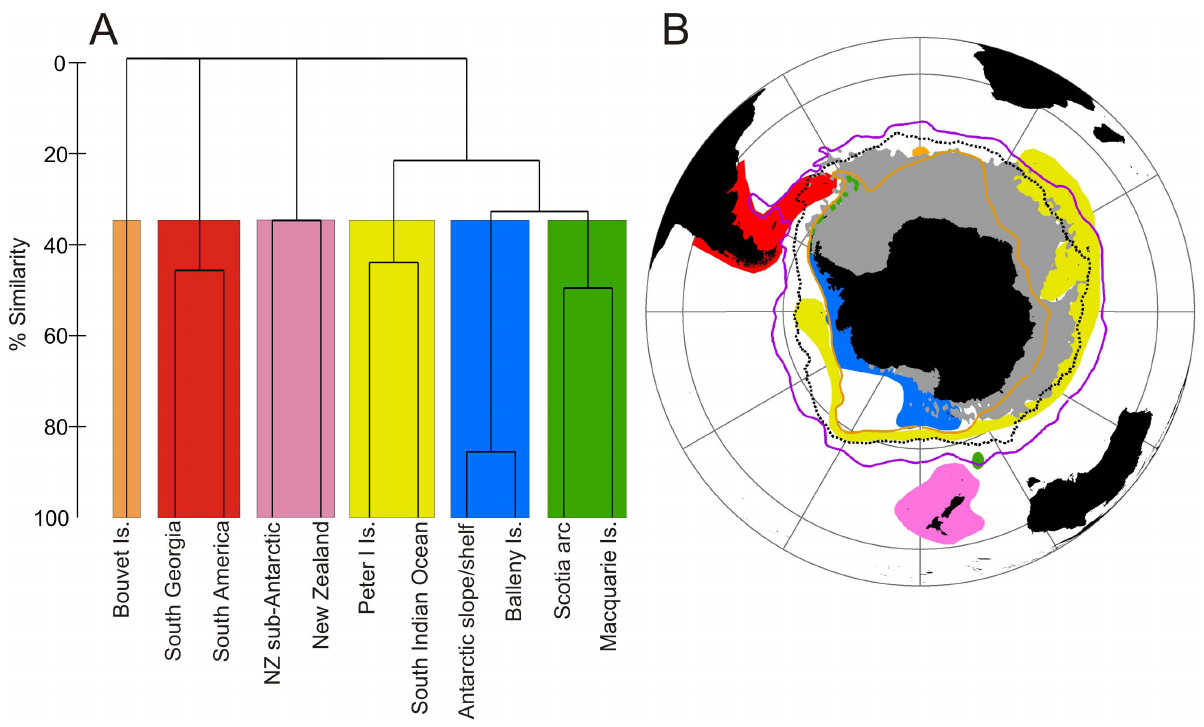
Figure 8. Biogeographic patterns in the distributions of the Lithodidae. Dendrogram of faunal similarity for Southern Ocean regions from Bray-Curtis similarities using complete linkage clustering. Coloured boxes represent biogeographic groupings at a 35% faunal similarity cut off value. Map of the geographic locations of the clusters. Black dotted line=Polar Front, purple solid line=Sub-Antarctic Front, orange solid line=southern Antarctic Circumpolar Current boundary (SACCB), grey=Seafloor temperature , 0 u C.